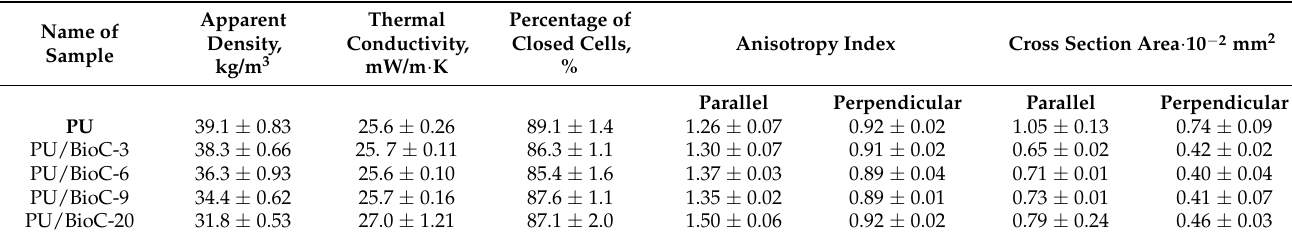
Table 2. Parameters of cellular structure and physical–mechanical properties of